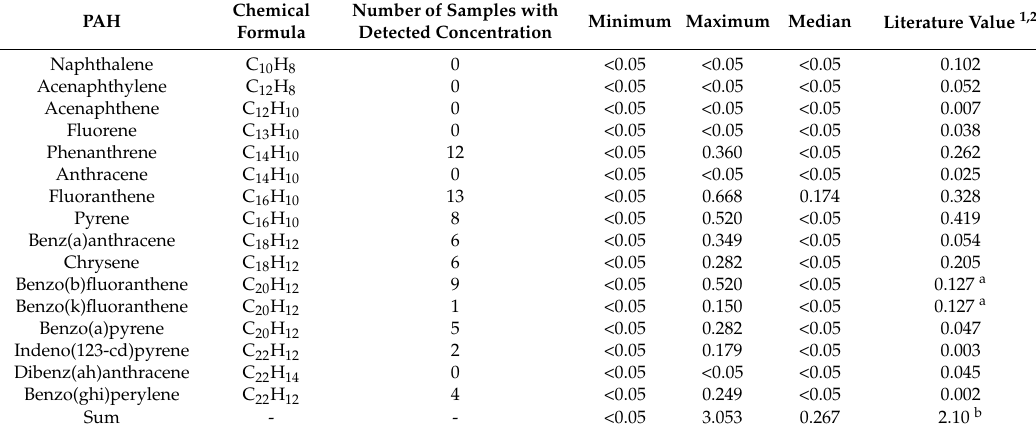
Table 4. Concentration of polycyclic aromatic hydrocarbons (PAHs) (mg · kg − 1 DM) in leaf litter of urban street trees in comparison to literature values for Quercus ilex leaves from Naples, Italy [17]. Minimum, maximum and median values refer to the full data set of 24